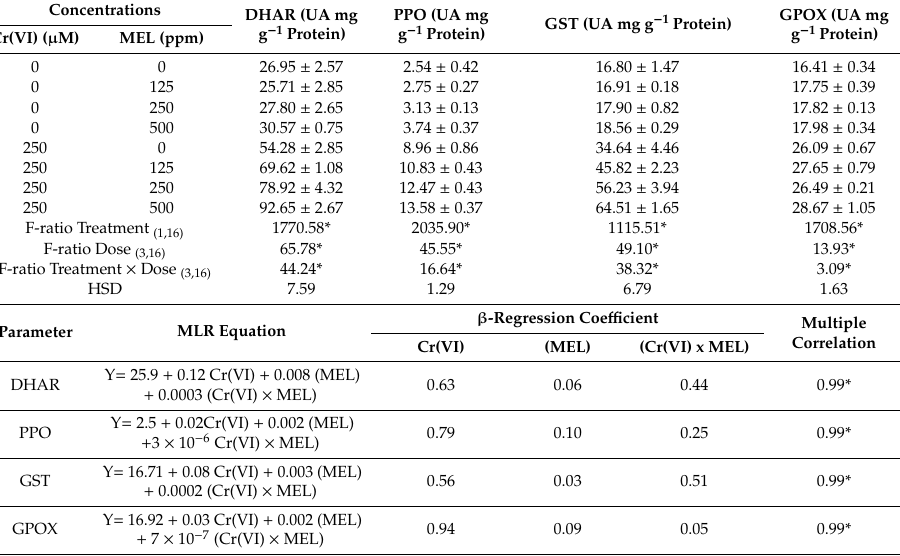
Table 5. E ff ect of Cr(VI), di ff erent concentrations of methanol extract of Rhododendron arboreum leaves (MEL), and their combinations on the activities of dehydroascorbate reductase (DHAR), polyphenol oxydase (PPO), glutathione S-transferase (GST), and glutathione peroxidase (GPOX) enzymes in 7-day-old Vigna radiata seedlings. The values are the means of three replicates ± SD. (standard deviation). Tukeys test performed and significance checked at * p ≤ 0.05. The F ratio is the term in which ANOVA is represented; Cr(VI) = Dose, MEL treatments = Treatment and combination of Cr(VI) and MEL = Dose × treatment.